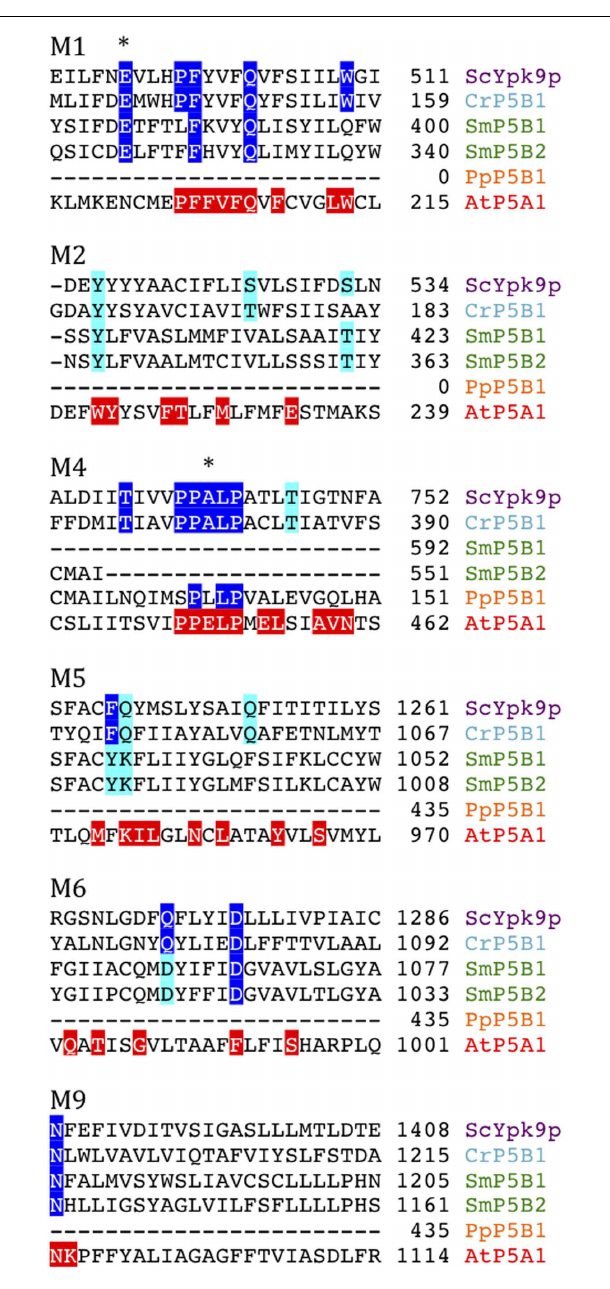
FIGURE 14 |Alignment of predicted transmembrane segments of putative P5BATPases aligned with similar regions in the S. cerevisiae P5BATPase ScYpk9p (Q12697). Residues conserved in all P5B ATPases (according to Sørensen et al., 2010) are marked in blue.Those that are highly conserved are marked in cyan.The P5A ATPase AtP5A/AtMIA is shown with residues conserved in P5A ATPases highlighted in red (Sørensen et al., 2010). Asterisks mark residues that are likely to play a role in ligand